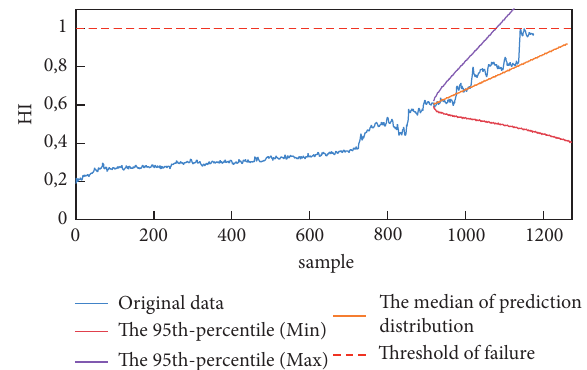
Figure 12: ARIMA-based prediction results for sample 2.